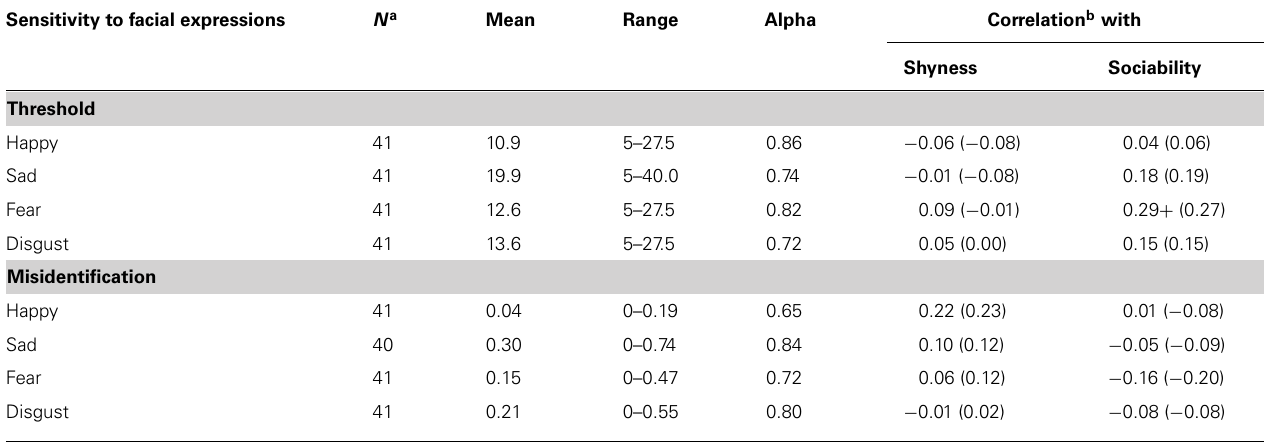
Table 1 | Descriptive statistics of expression sensitivity measures and their correlation with temperament in Experiment 1. Sensitivity to facial